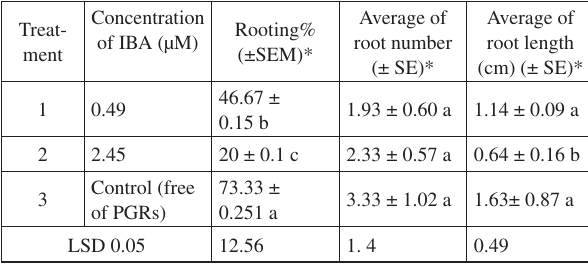
Table 2. Effect of IBA concentration on rooting parameters in vit ro in A. halimus L. within 4 weeks of culture on rooting media